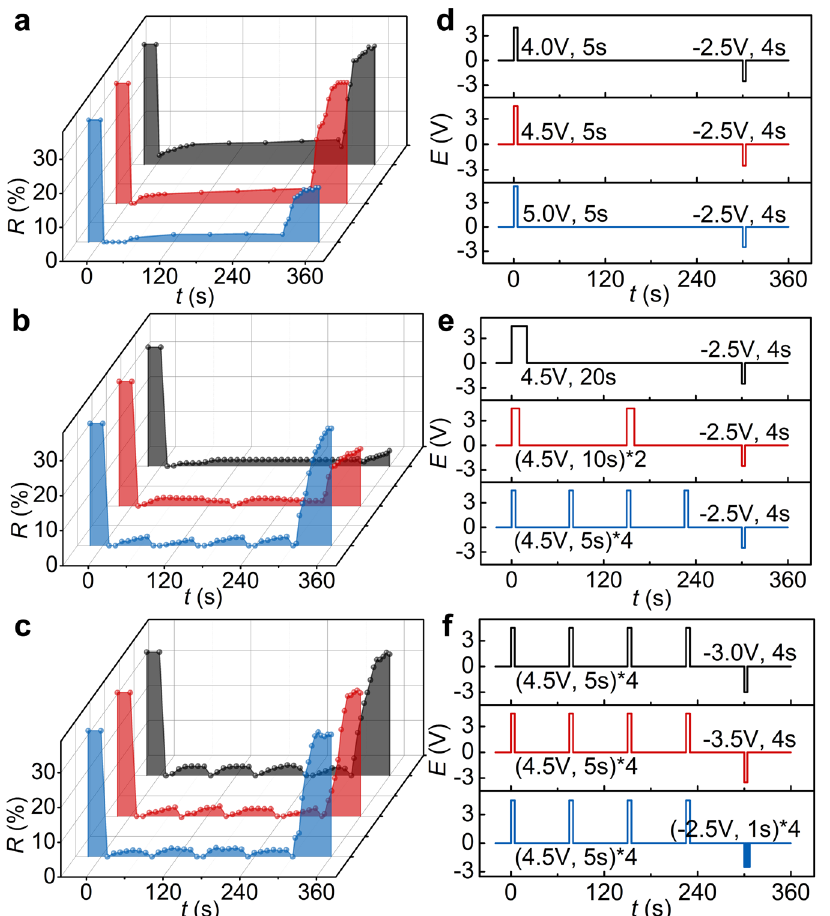
Fig. 3 | Modulation of the applied E- fi eld. The bistability of SiO 2 /PCb-PEG-EG ERPCs (30/60/5/5vol%) evaluated by a – c the time evolution of re fl ection intensity under different E- fi eld waveforms, including d a strength modulation and e an intermittent modulation of the forward voltage, and f an impulsive modulation of